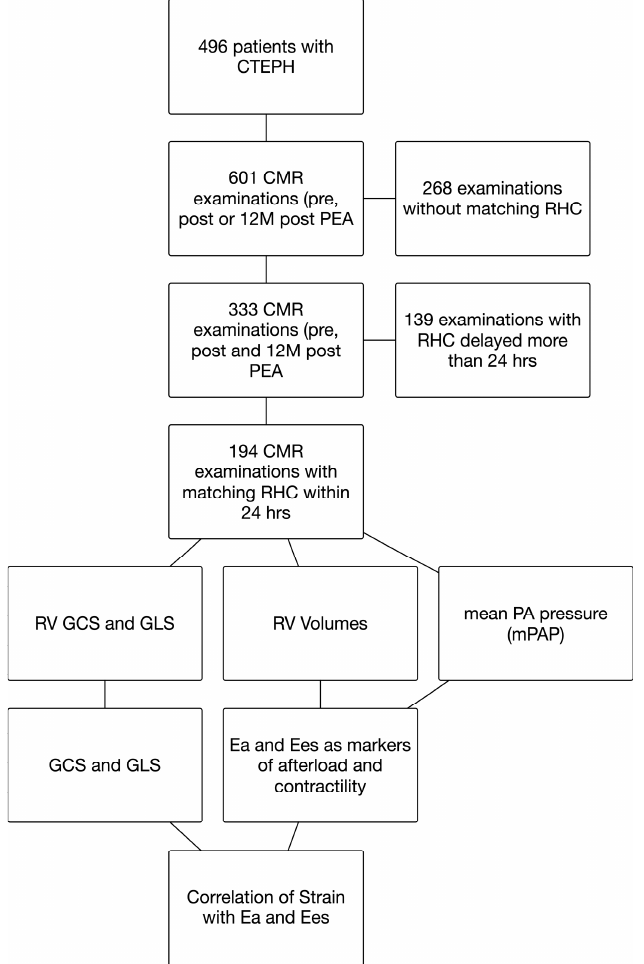
Figure 1. Patient selection and analysis procedure. CMR—cardiac magnetic resonance, RHC—right heart catheter, GCS—global circumferential strain, GLS—global longitudinal strain, RV—right ven- tricle, Ea—effective arterial elastance, Ees—effective elastance of the RV, PA—pulmonary artery.